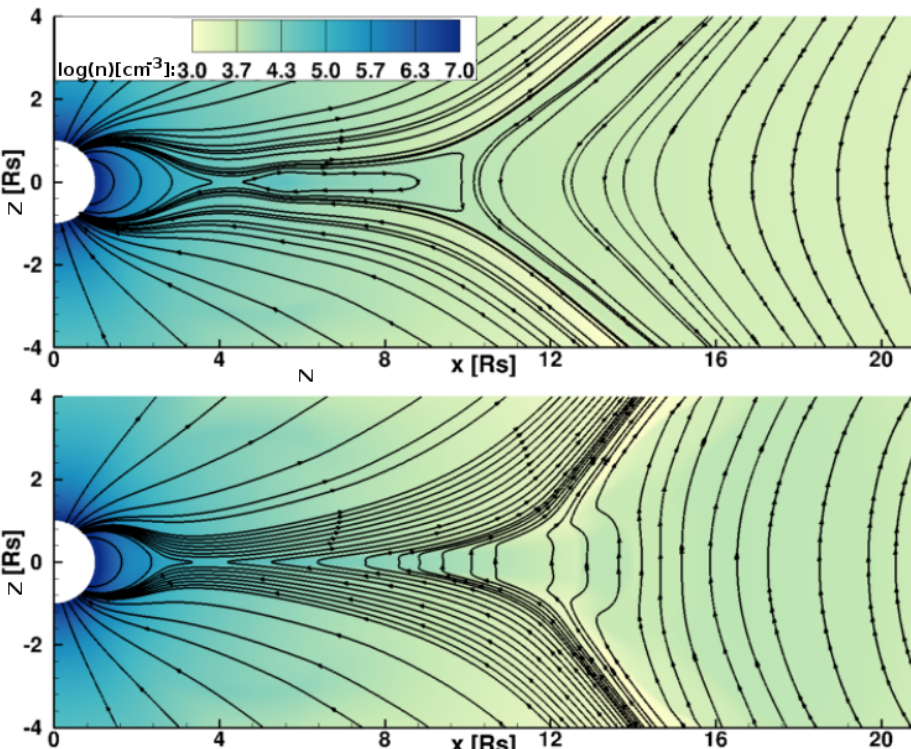
Figure 9. Snapshot of the number density (colour coded) and of selected magnetic field lines in the rear parts of two CMEs with an initial velocity of 800 km/s ejected in a medium density wind, 13 h after initiation. The CME in the upper panel has a normal polarity while the CME in the lower panel has an inverse